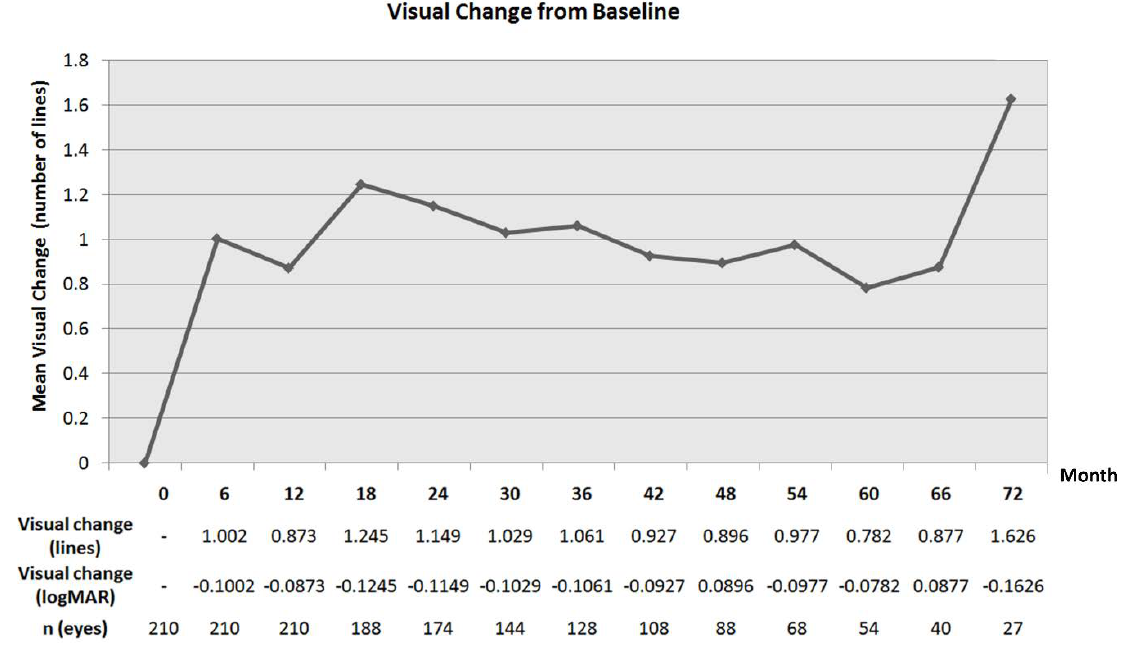
Figure 2. Mean visual change from baseline over time. The mean change in visual acuity from baseline is noted in logMAR and equivalent of